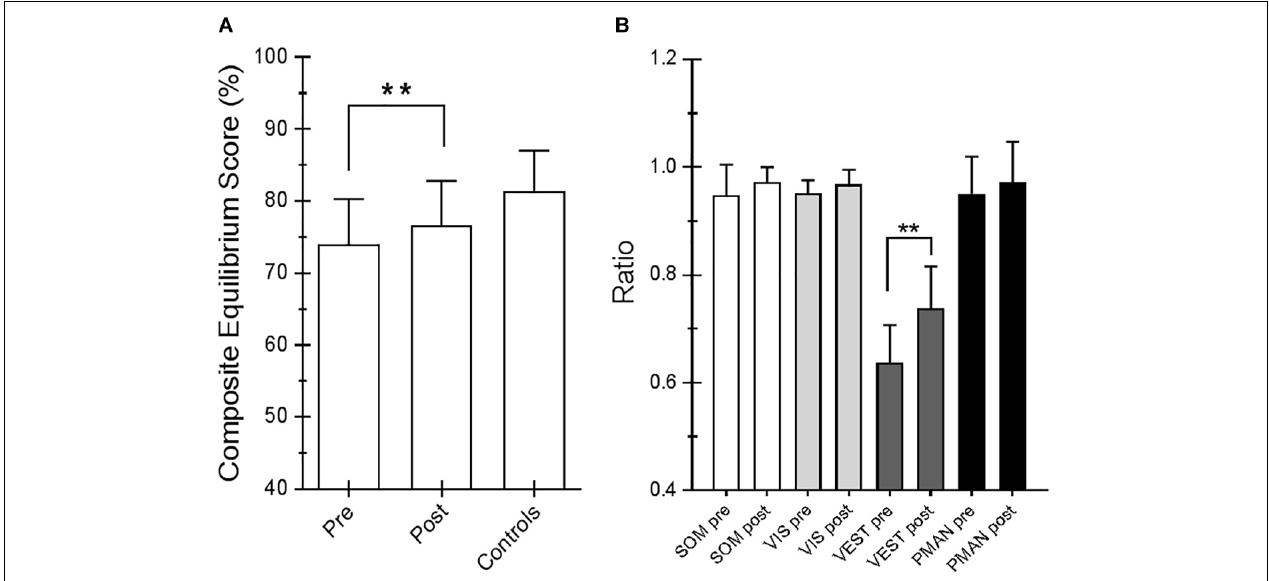
FIGURE 2 | (A) Equilibrium score (ES) composite pretraining and posttraining with Angel’s Wings and the control values. (B) Somatosensory ratio composite pretraining and posttraining with Angel’s Wings and in the controls subjects. “SOM” refers to the sway increase when visual information is removed; low scores: poor use of somatosensory references. “VIS” refers to the sway increase when somatosensory information is removed; low scores: poor use of visual references. “VEST” refers to the sway increase when visual information is removed, and the somatosensory information is incorrect; low scores: poor use of vestibular information or no vestibular information. Statistical analysis is performed between pretraining and posttraining only in Parkinson’s disease (PD) subjects. Values are reported as mean and standard deviation. ∗∗ p = 0.02 (Wilcoxon matched-pairs signed rank